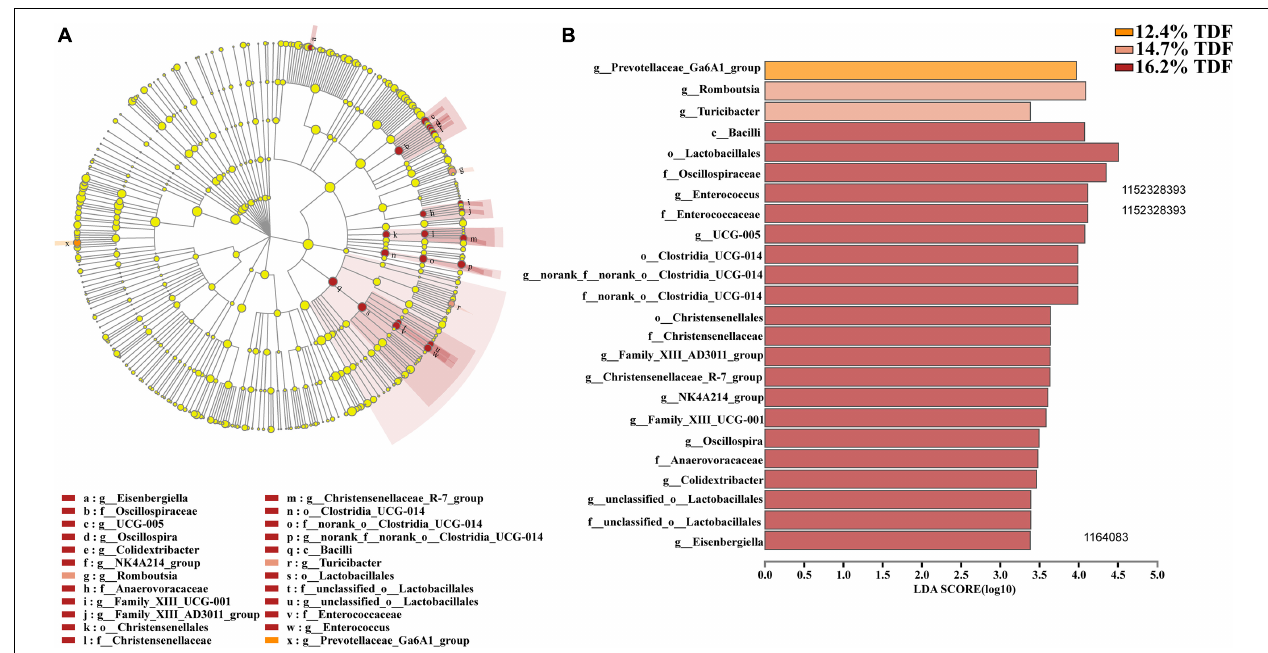
FIGURE 6 | Effects of total dietary fiber on Linear discriminant analysis effect size (LEfSe) to detect the most significantly abundant cecal microbiota of White Pekin ducks on day 35 among three groups. (A) cladoram measured from LEfSe analysis; (B) LDA score generated for differentially abundant microbiota (LDA > 2, P <